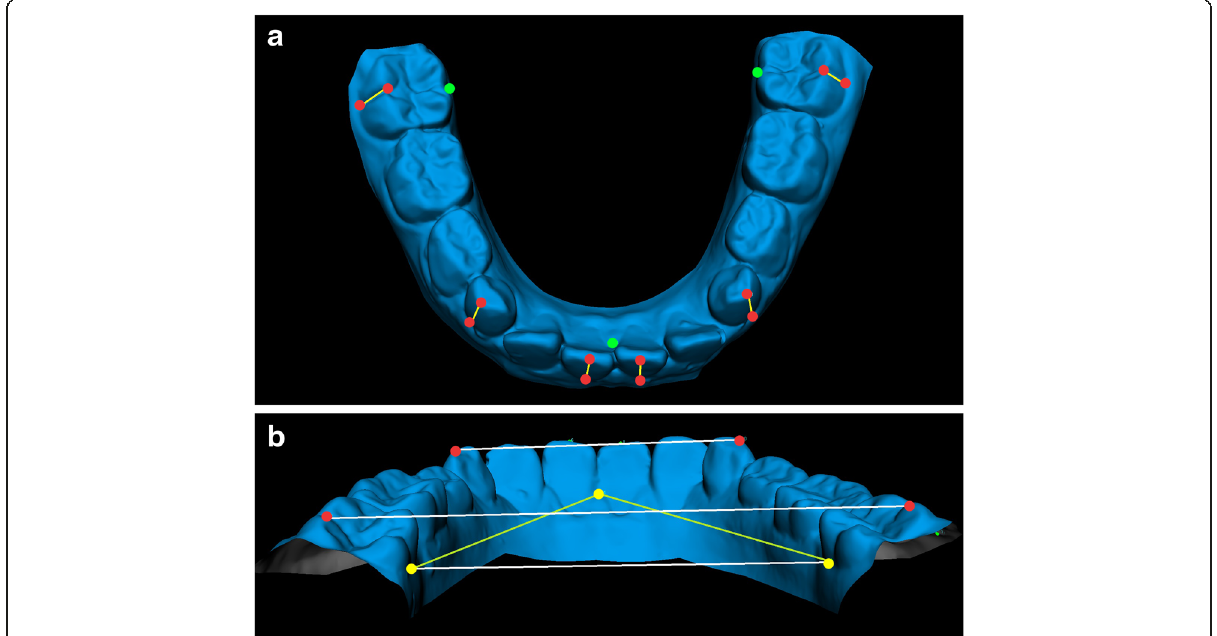
Fig. 1 a , b . Digital model of the mandible with markers: dental markers in red , reference plane markers in green . a FACC, used to calculate angulation, in yellow . b Intercanine and intermolar (lingual and vestibular) distances in